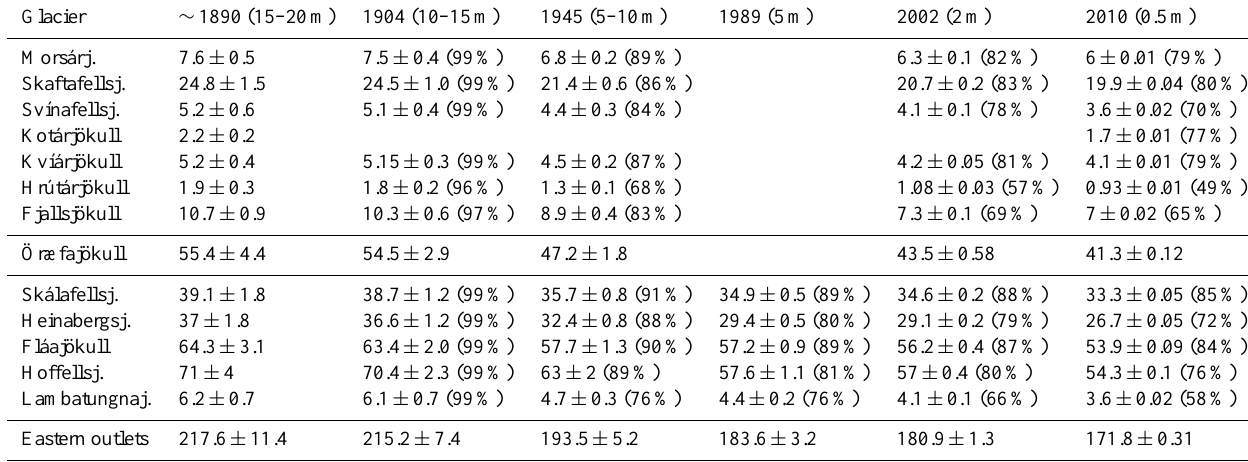
Table 4. Volume of the southeast outlet glaciers derived from glacier surface DEMs and the bedrock DEM at different times in km 3 . Percentage is relative to the ∼ 1890 volume. The estimated point accuracy of the elevation is in parenthesis. Glacier